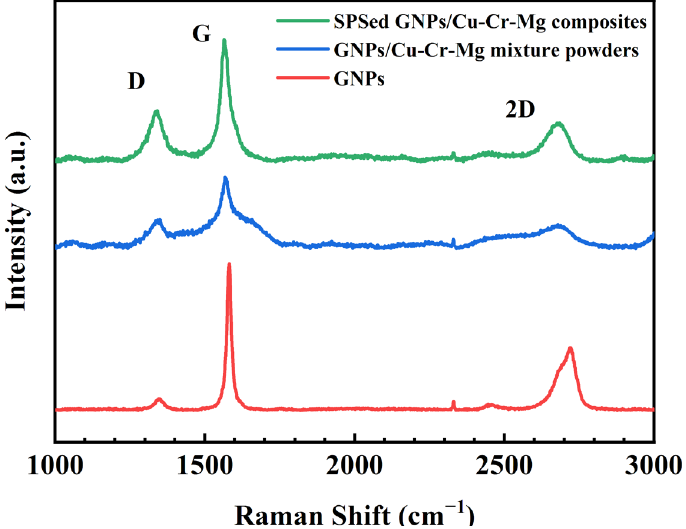
Figure 6. Raman spectrum of a GNPs/Cu–Cr–Mg composite.